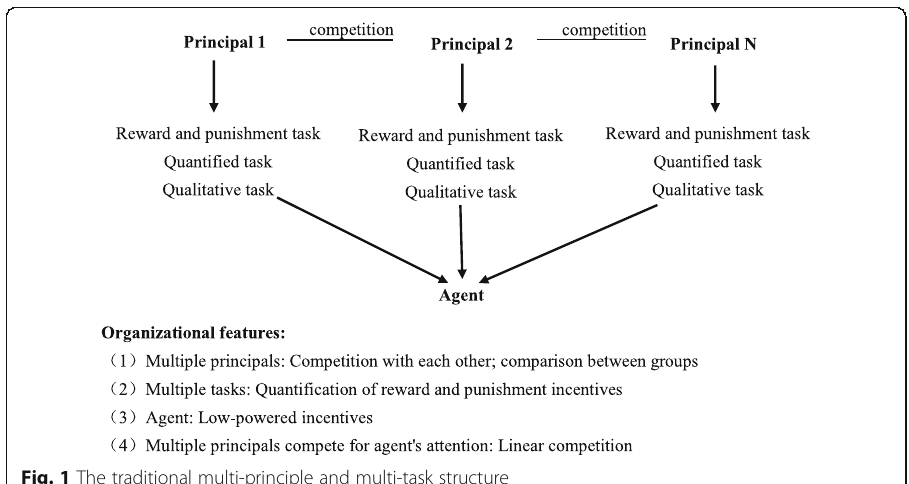
Fig. 1 The traditional multi-principle and multi-task